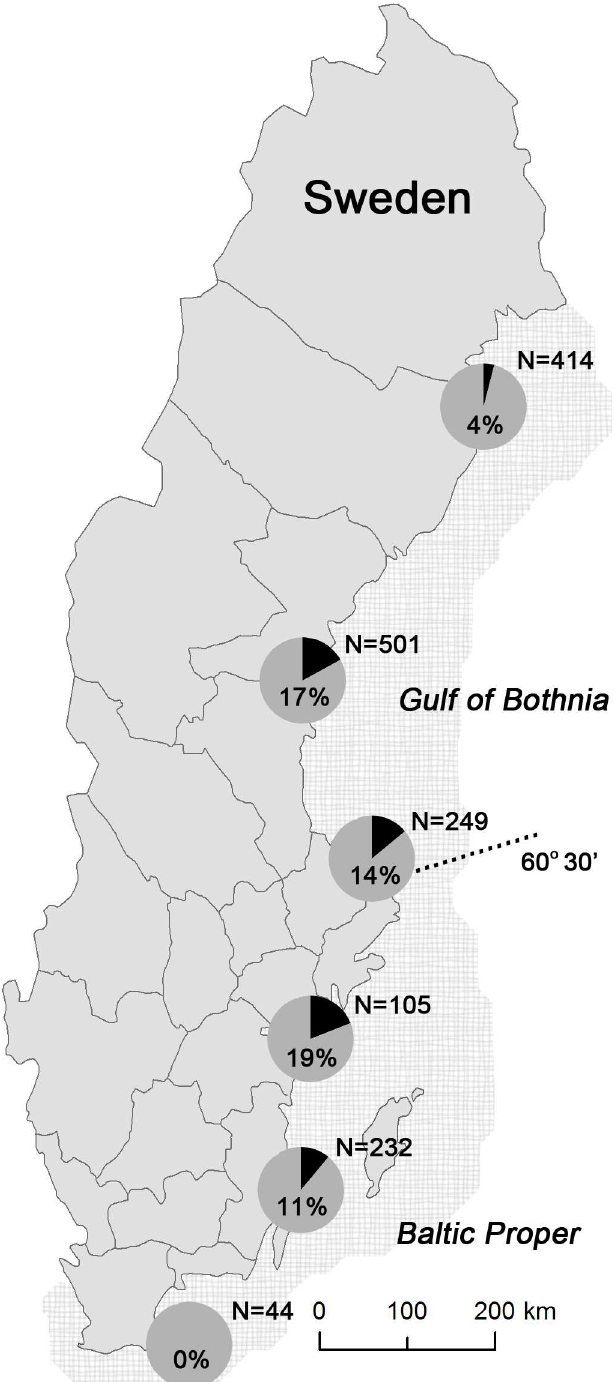
Fig 1. Map of Sweden indicating where grey seals ( Halichoerus grypus ) were collected showing the proportion of seals infected with Pseudamphistomum truncatum from 2002–2013. Data are grouped to represent two adjacent counties at once. Pie charts illustrate the proportion of infected seals per total number of animals examinedfrom each pair of counties.